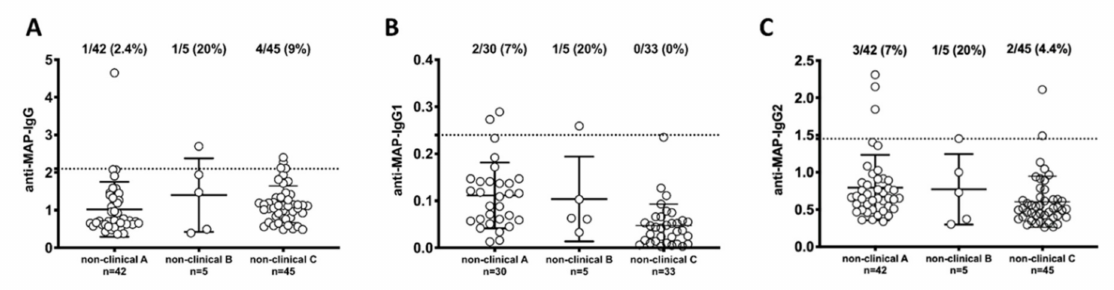
Figure 1. Anti- Mycobacterium avium subsp. paratuberculosis (MAP) titers in serum from dogs raised at three non-clinical institutes in Japan. ( A ) titers anti-MAP-IgG, ( B ) titers anti-MAP-IgG 1 , ( C ) titers anti-MAP-IgG 2 . Dot plot showing the distribution of total IgG detected by ELISA. The horizontal bars represent the median plus interquartile range, while the percent fraction of antibody positive sera is indicated on top of distribution. Cut-o ff values for positivity, calculated by ROC analysis, are indicated by dashed lines.